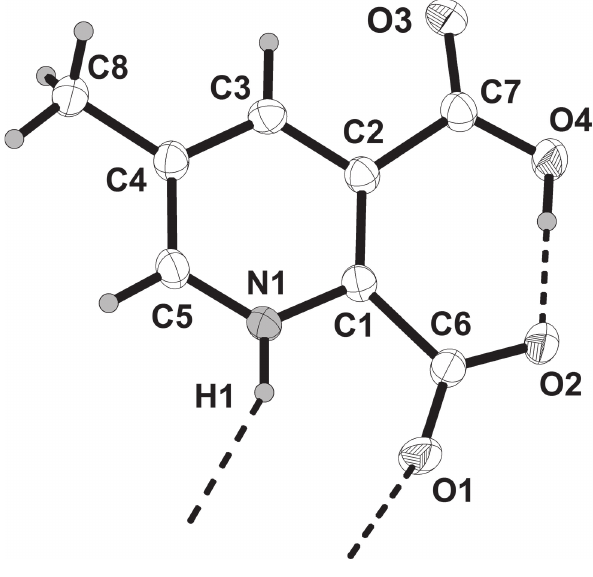
Table 1: Data collection and handling.